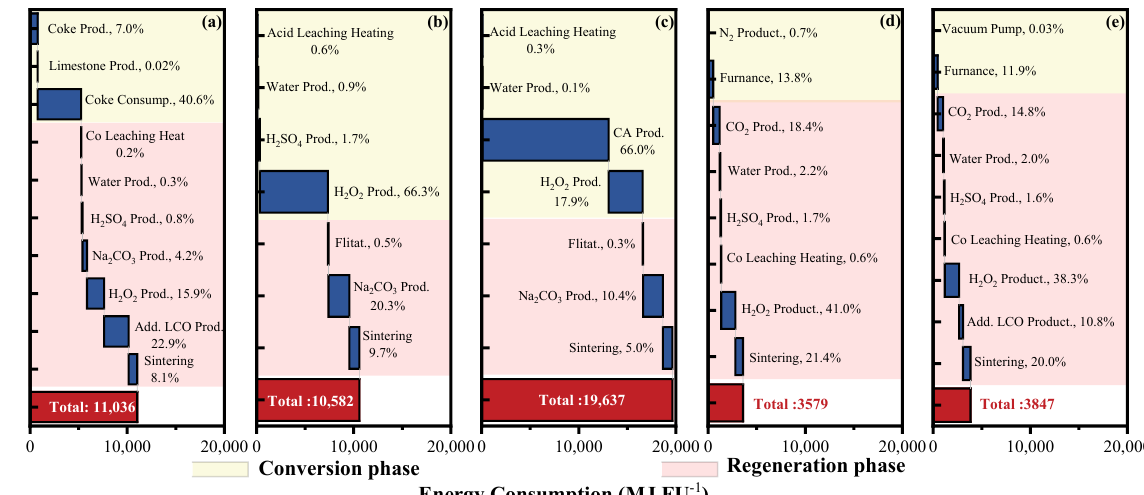
Figure 6. Contribution analysis of the energy consumption in the conversion and regeneration phase for the five different recycling methods. ( a ) UHT method, ( b ) HM-SA, ( c ) HM-CA, ( d ) RR-N 2 , and ( e ) RR-Vac. The percentage labeling indicates the proportion of the energy consumption associated with the manufacture of the materials or active electrode material processing needed for the treatment of 1FU in the conversion and regeneration phase. The red bar indicates the total energy consumption of the conversion and regeneration phase for the five different recycling methods.